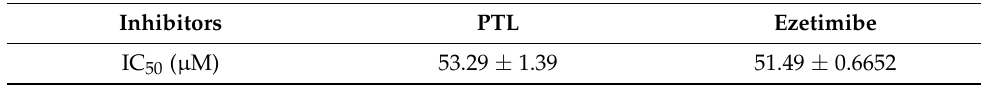
Table 1. IC 50 value of PTL for inhibition of cholesterol uptake.